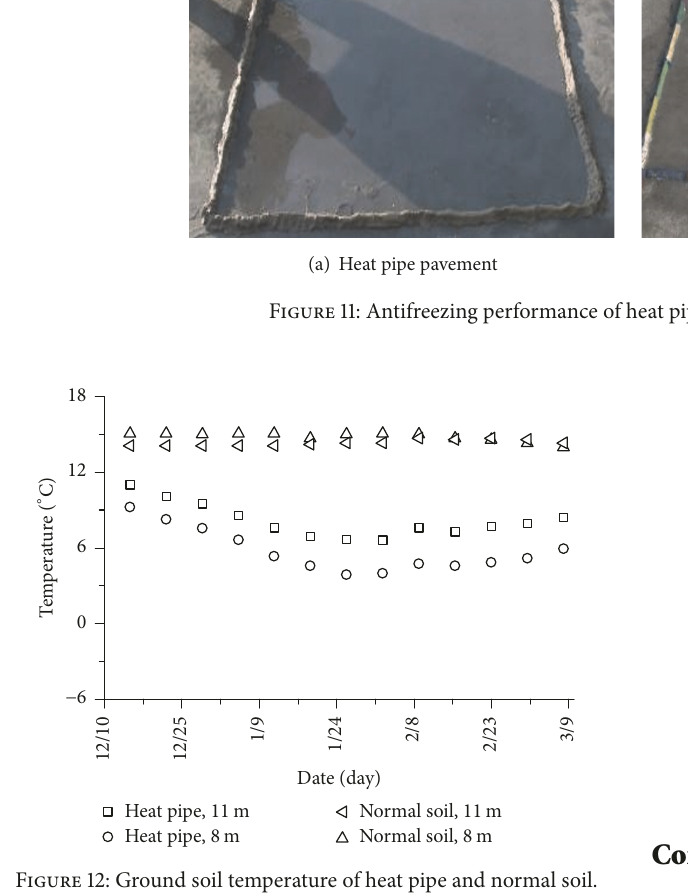
Figure 12: Ground soil temperature of heat pipe and normal